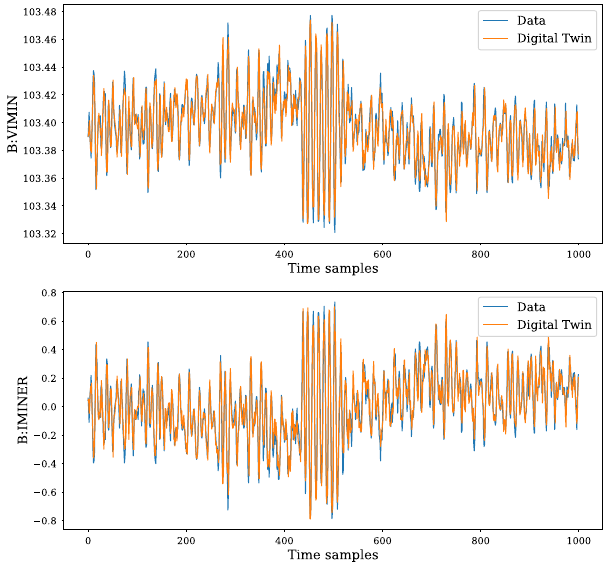
FIG. 6. Selected test data (blue) versus prediction values (orange) from the Booster LSTM surrogate model. New data is fed into the trained surrogate model at each